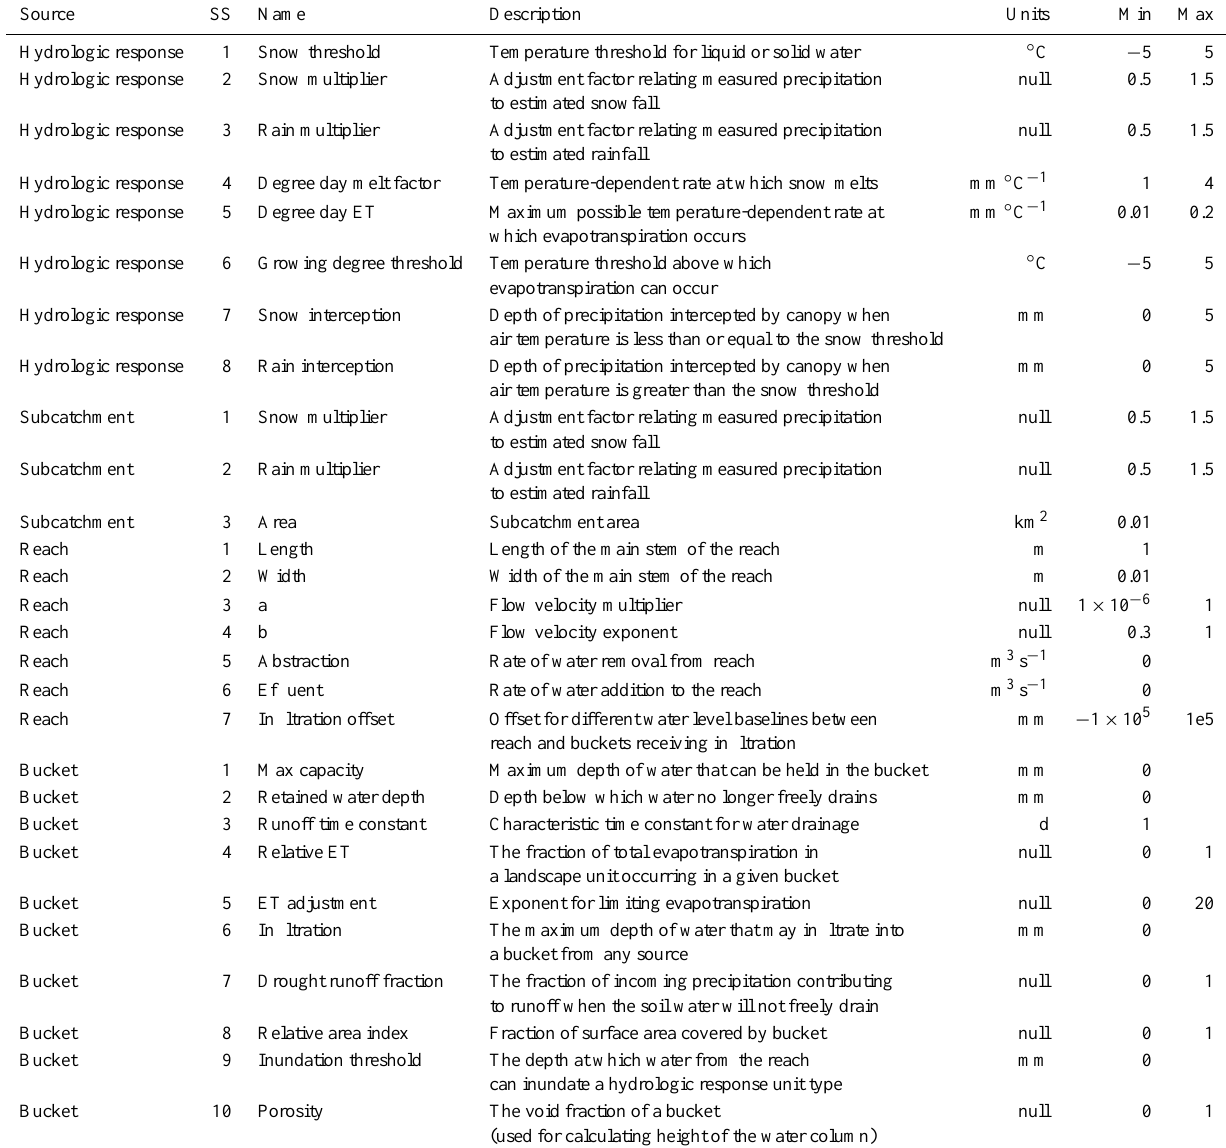
Table 1. Model parameters applicable at a hydrologic response type ( l 1 – l 6 ) , subcatchment ( s 1 – s 3 ) , reach ( r 1 – r 7 ) and bucket ( b 1 – b 10 ) level. “SS” indicates the subscript used for parameter identification. The min and max values represent suggested parameter